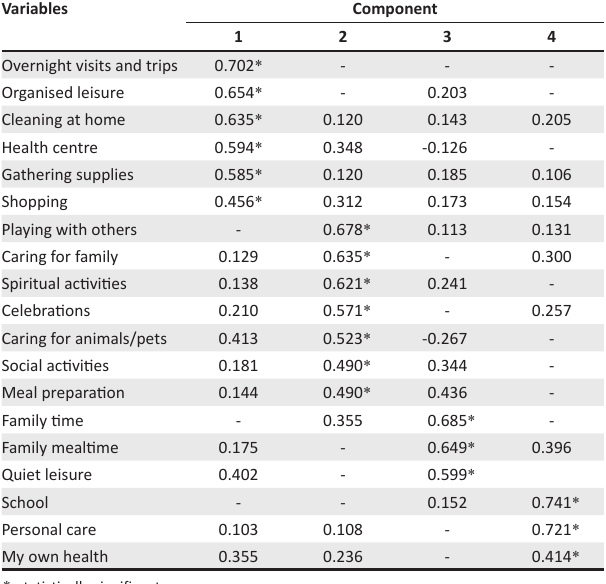
TABLE 4: Principal component analysis – Rotated component matrix.